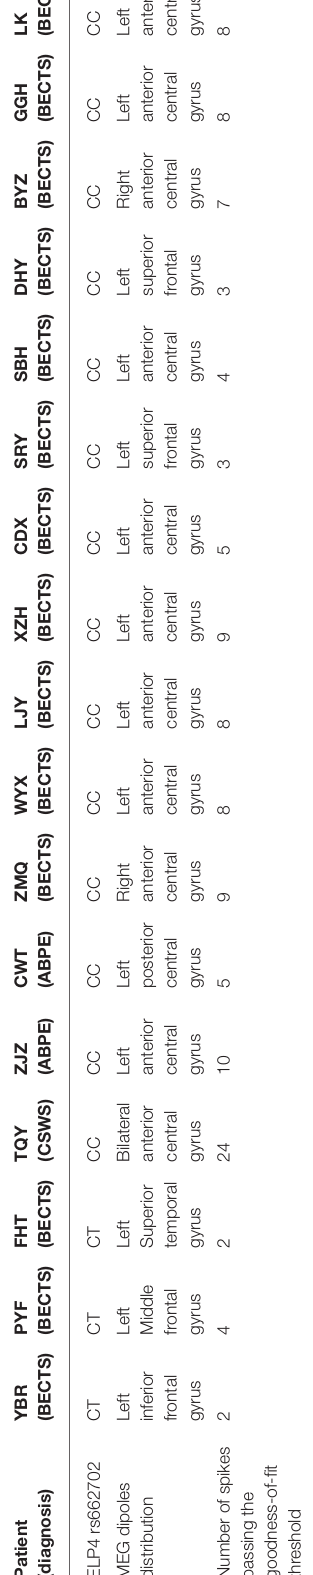
the MEG CTS source locations, shown by dipoles, are shown in Figure 1